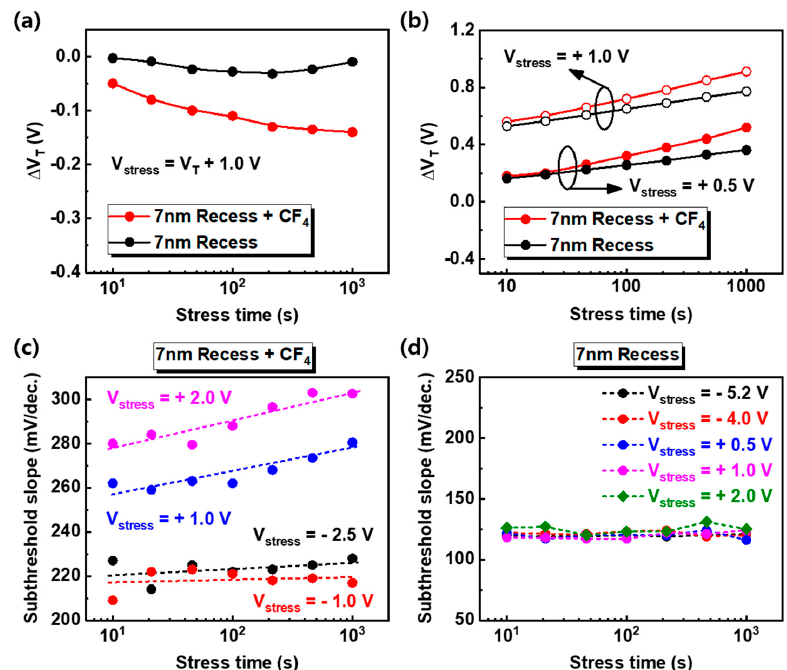
Figure 7. The V T shift by gate bias stress according to stress time. A ( a ) negative (V T + 1.0 V) and ( b ) positive gate bias stress were applied to the devices. The red and black circle line indicate the 7-nm recess + CF 4 and 7-nm recess devices, respectively. ( c , d ) The change in the subthreshold slope for various gate bias stress corresponding to the stress time. The negative biases near the V T and positive bias at 1.0 V and 2.0 V were used to estimate the degradation phenomenon.